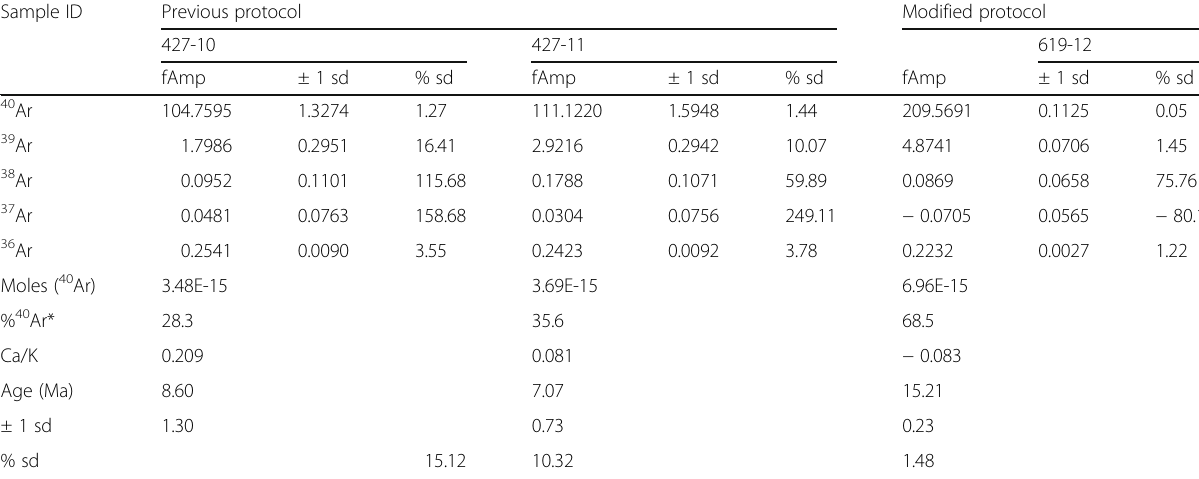
Table 2 Ar isotope analyses of representative aliquots of